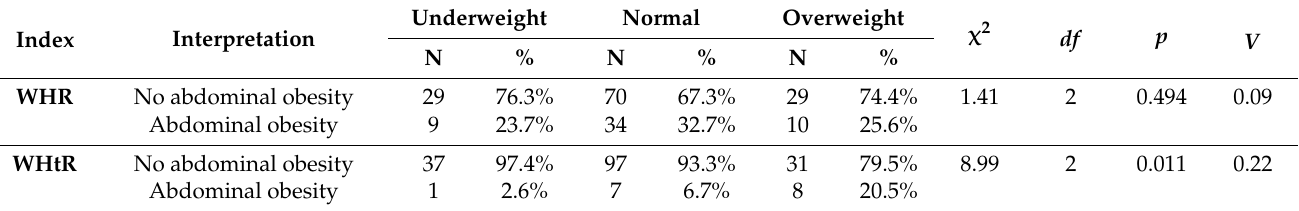
Table 3. Interpretation of the WHR and WHtR index taking into account the